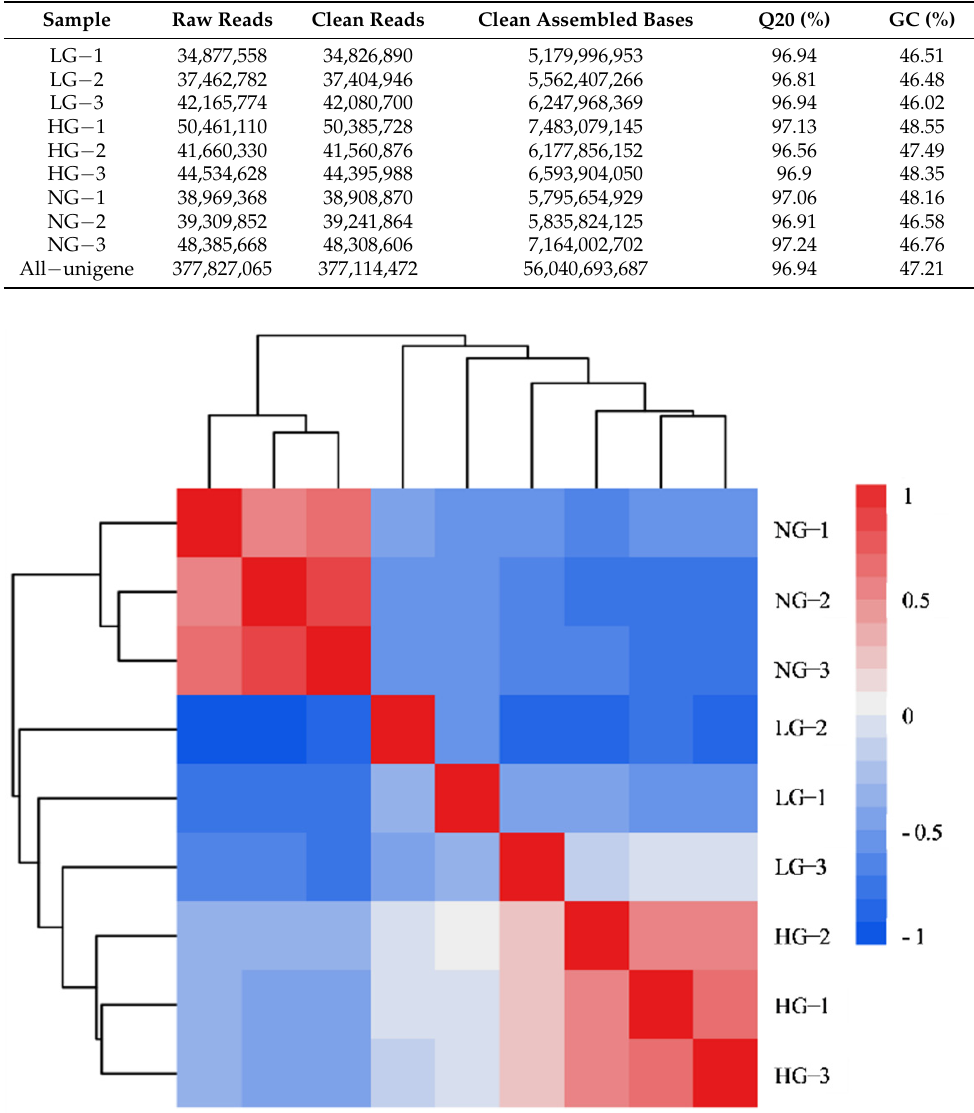
Table 1. Sequencing the T. mongolicum transcriptome in nine samples from plants that were light grazing treated (LG − 1, LG − 2, LG − 3), heavy grazing treated (HG − 1, HG − 2, HG − 3), and non − grazing − treated (NG − 1, NG − 2, NG − 3).